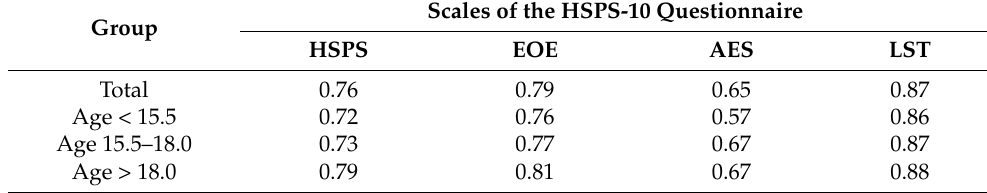
Table 3. Reliability of the HSP scale–the Cronbach’s α coefficients of the scales of the short version of the HSPS-10. Scales of the HSPS-10 Questionnaire Group HSPS EOE Total